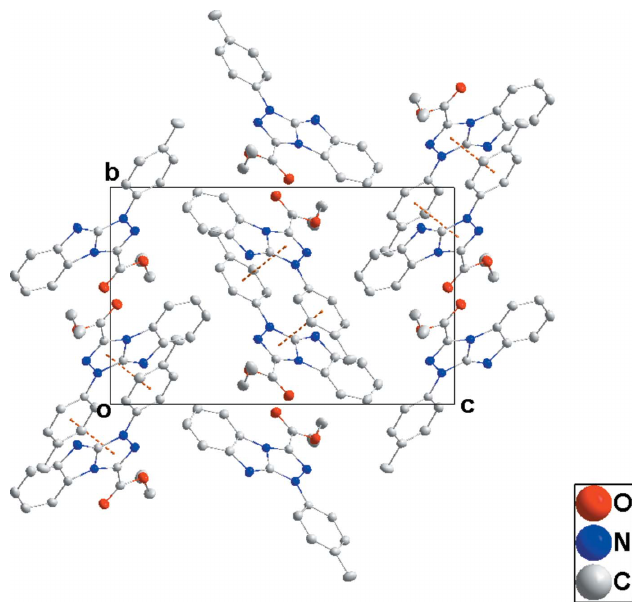
Figure 2 Packing viewed along the a -axis direction with (cid:2) -stacking interactions shown as dashed lines.